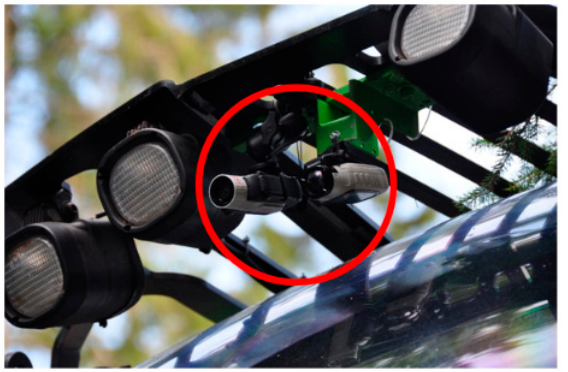
Figure 5. Installed video capturing technology at the protective grating above the front windscreen for recording harvesting activities. The second camera ensured data recording in case of failures.